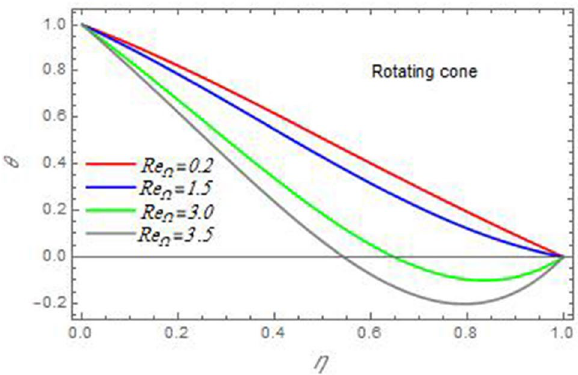
Figure 17. The temperature distribution θ is plotted versus the axial variable η in the case of stationary disc to depict the effect of the Reynolds number Re (cid:31) .